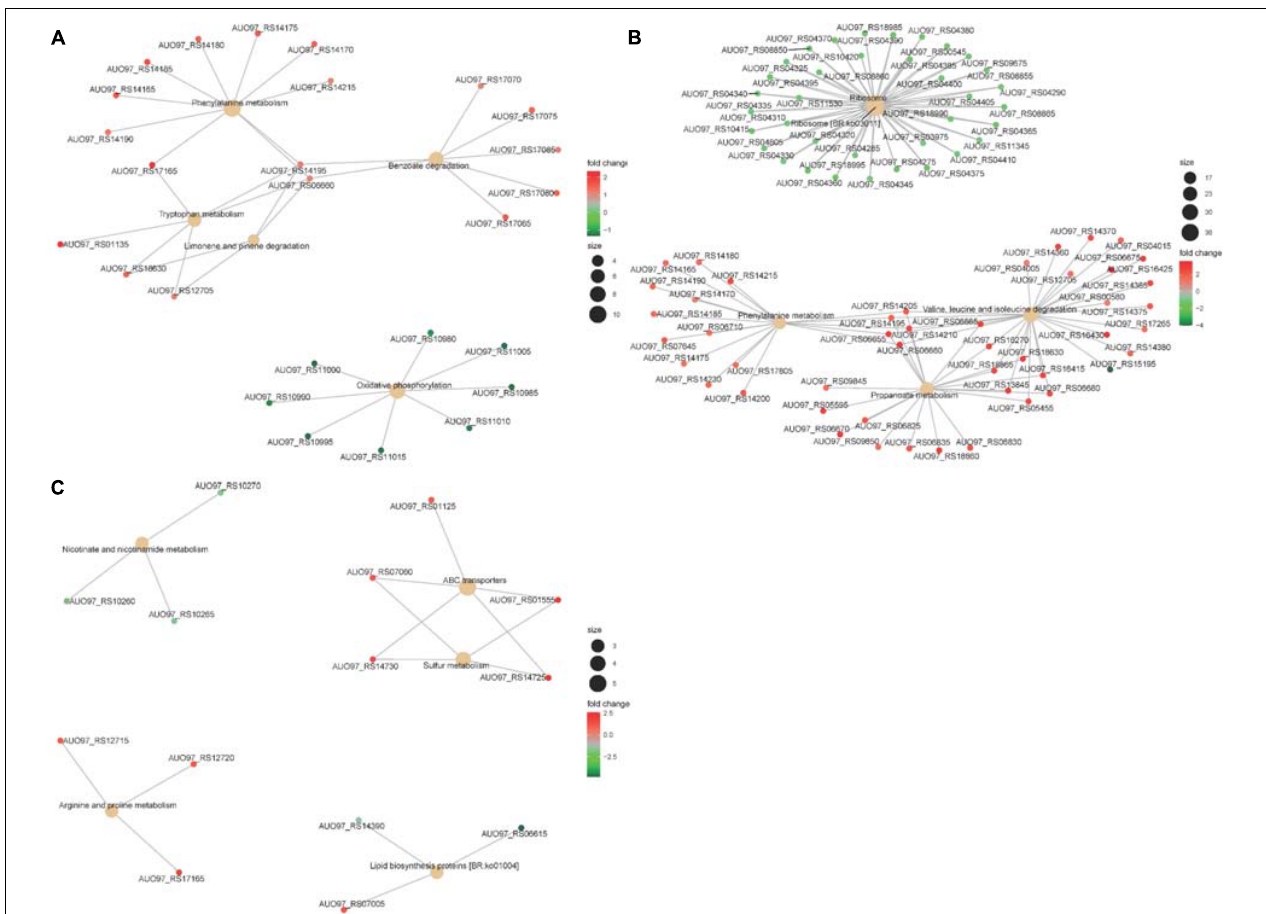
FIGURE 8 | (A) The top five significantly enriched KEGG pathways of DEGs in (cid:49) abaI . The size of the nodes shows the number of genes enriched in each pathway. The color gradient shows the log2-fold change of gene expression. (B) The top five significantly enriched KEGG pathways of DEGs in (cid:49) abaR . The size of the nodes shows the number of genes enriched in each pathway. The color gradient shows the log2-fold change of gene expression. (C) The top five significantly enriched KEGG pathways of DEGs in (cid:49) abaIR . The size of the nodes shows the number of genes enriched in each pathway. The color gradient shows the log2-fold change of gene